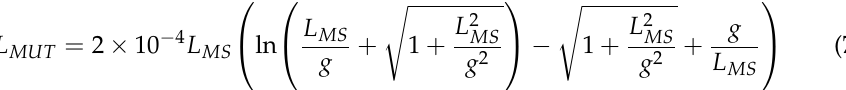
In Equations (4)–(6), W EFF determines the effective line width, L MS represents the length of the metal (copper) segment, H MS denotes the height of the metal segment. Sim- ilarly, n indicates the number of turns in the coil inductor, C 1 and C 2 are demonstrated the linearized parameters for the inductance and resistance, respectively. The mutual inductance of the designed sensor mainly depends on the gap between segments and can be defined as [31]: